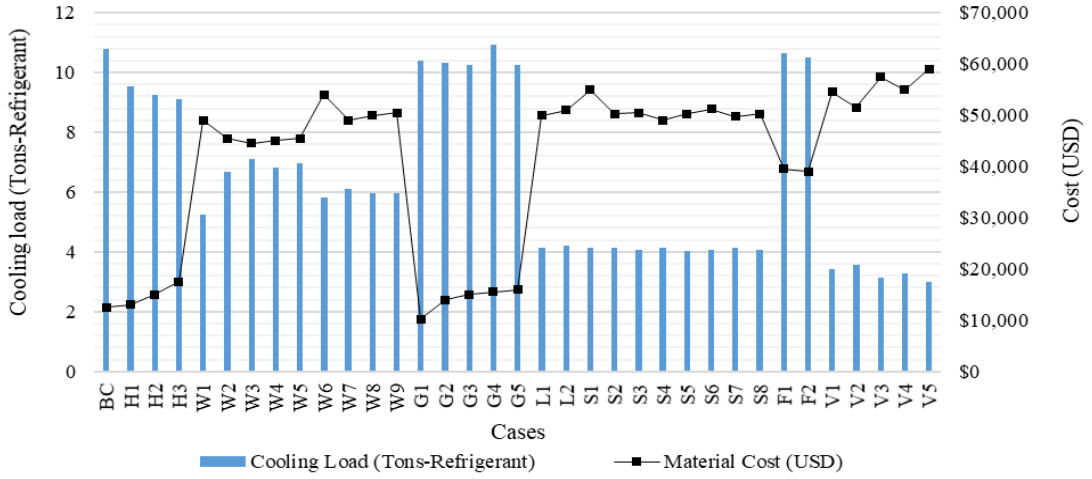
Figure 3. The peak cooling load and materials cost for all considered cases.